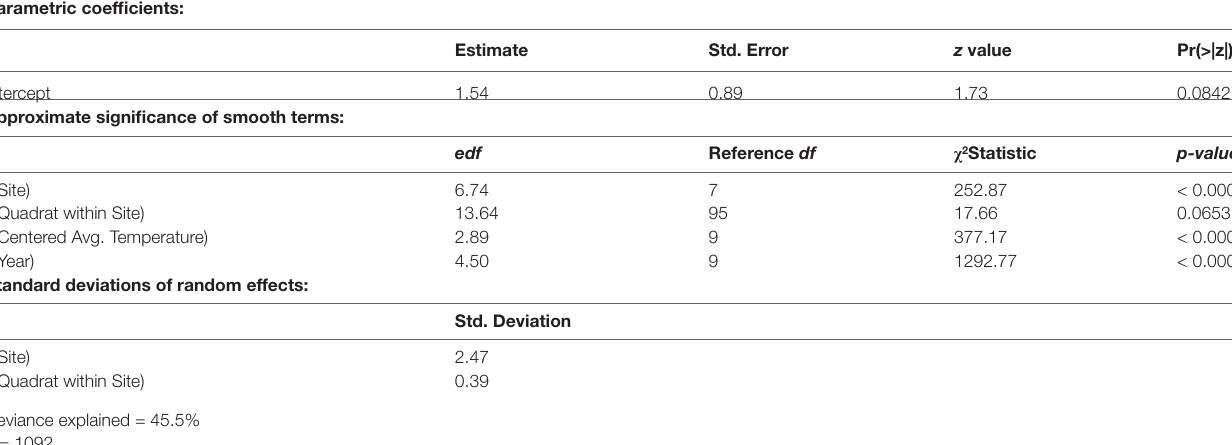
TABLE 2 | Eelgrass presence/absence component GAMM (binomial response distribution with logit link function) summary. Parametric